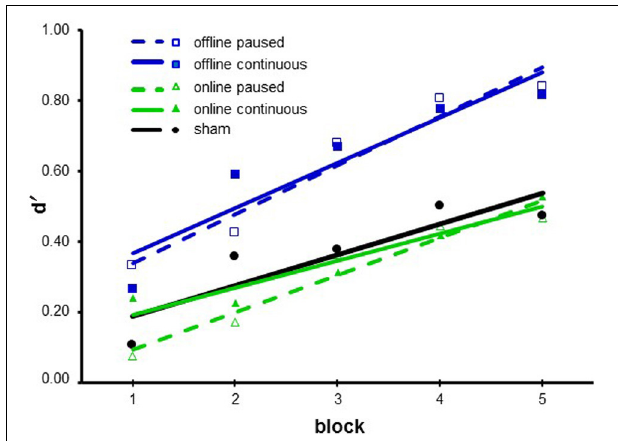
FIGURE 3 | Results of Experiment 1. Data are presented as the mean d (cid:4) values. The lines represent the fit of each condition. The blue lines represent the offline conditions, and the green lines represent online conditions. The dashed lines represent the paused stimulations, whereas the continuous lines represent the continuous stimulations. The sham condition is shown in black.